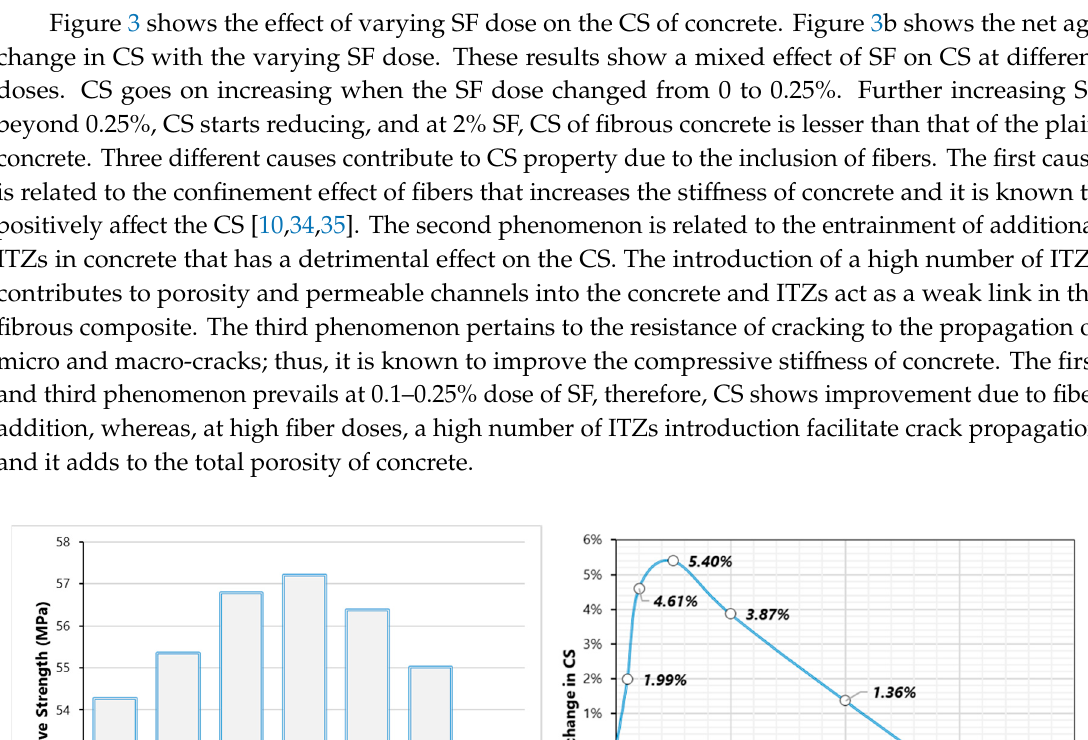
Table 3. Overview of mechanical and permeability testing methods and schedule.